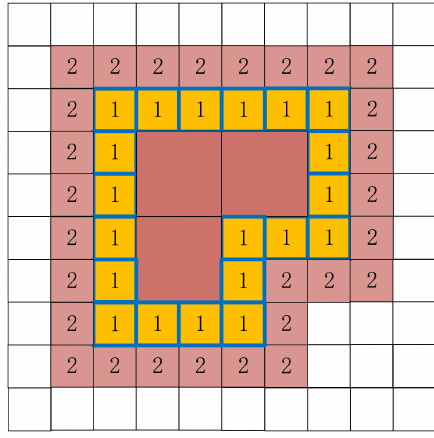
Figure 11. Voronoi